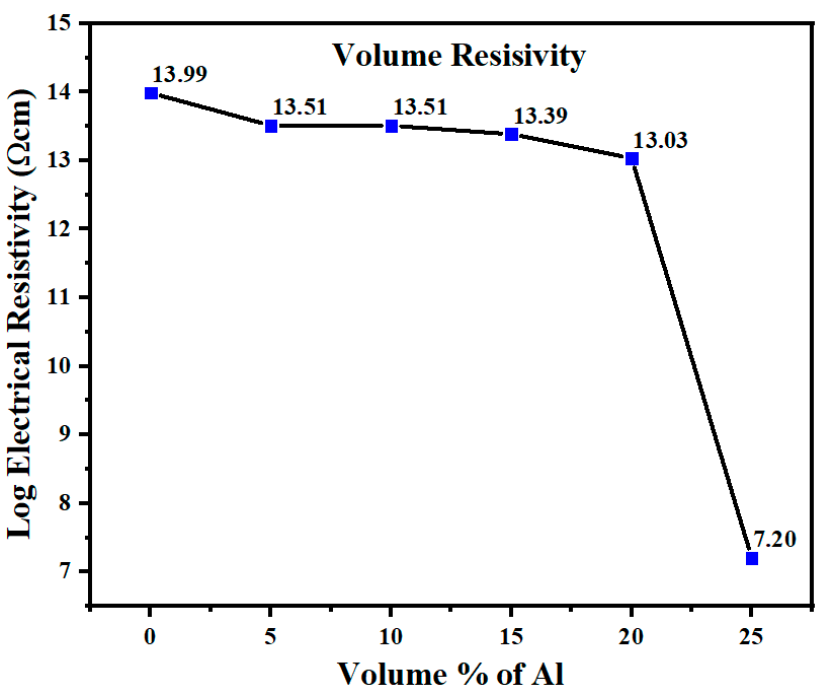
Table 3. Resistivity and conductivity at 20 °C of a range of materials.